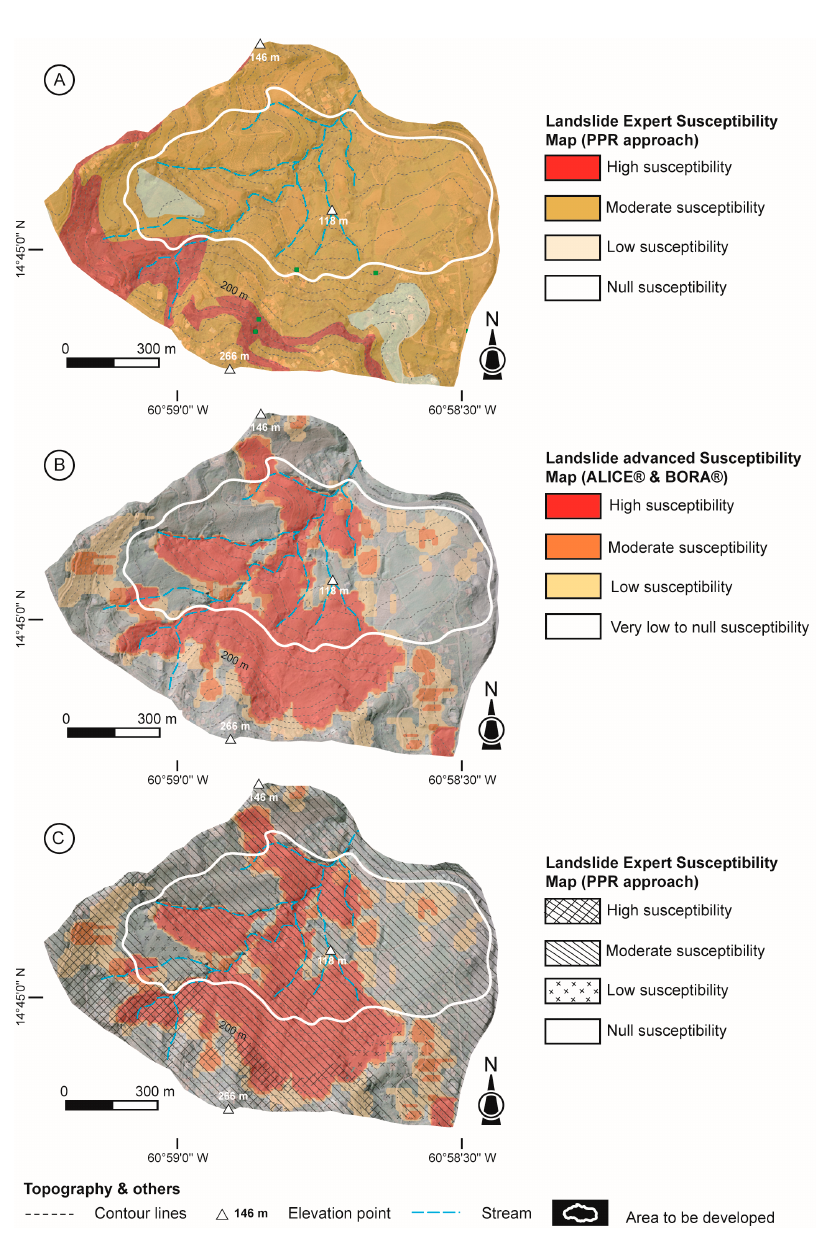
Figure 13. ( A ) Landslide Expert Susceptibility Map produced by the PPR approach; ( B ) combined landslide advanced susceptibility map produced with ALICE ® and BORA ® (for shallow and deep; translational and rotational landslides); ( C ) superposition of the two maps ( A , B ). (Coordinates are expressed in Lat/Long; projection WGS84 UTM 20N—EPSG 32620.)